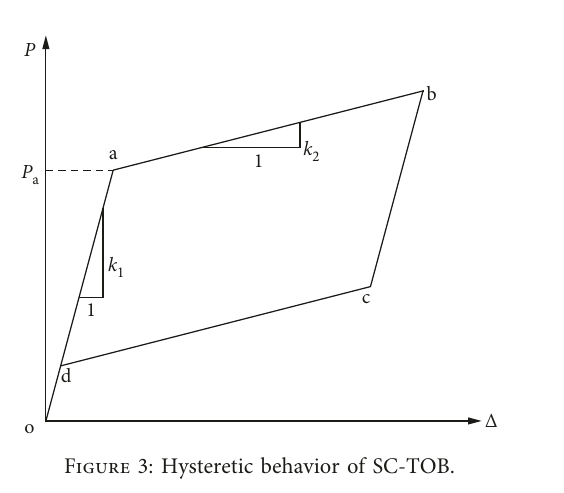
Figure 3: Hysteretic behavior of SC-TOB.